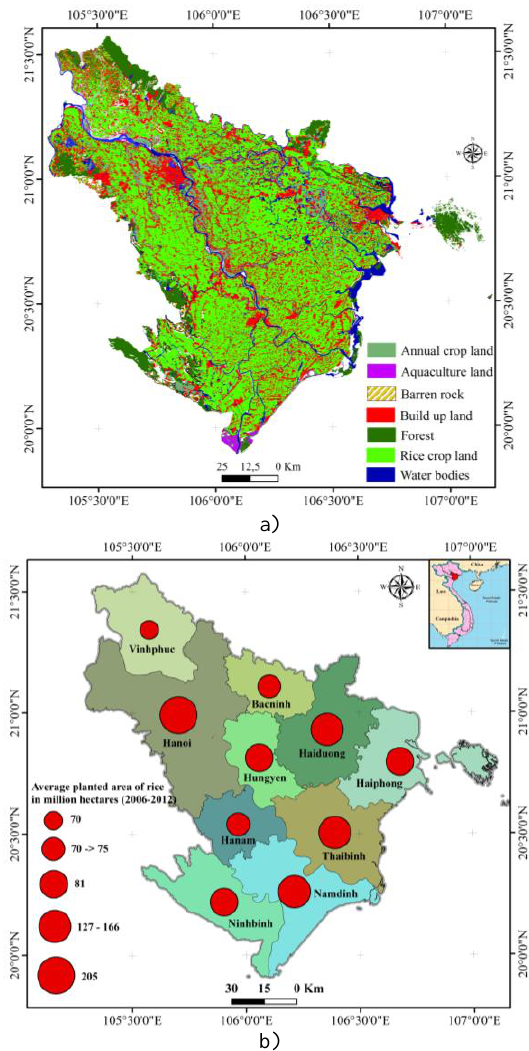
Figure 5. (a) Land use & land cover map of the RRD in 2010 (b) Average of planted area of rice by province and by